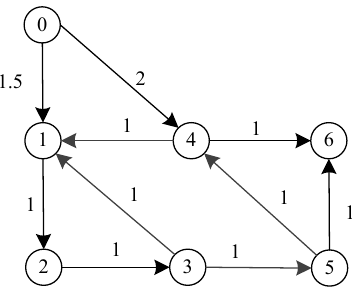
Figure 2. The communication